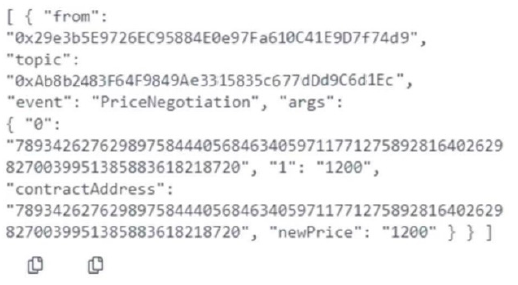
Figure 5. Price negotiations between supply and demand.